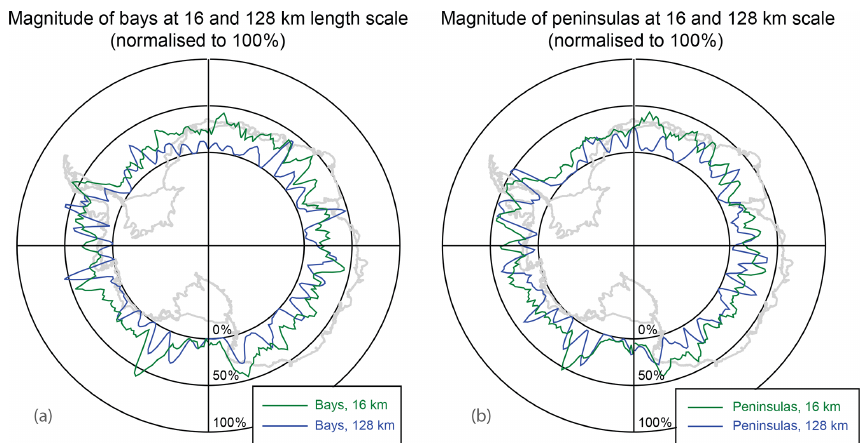
Figure 8. Polar plot showing normalized C x for (a) bays and (b) peninsulas around Antarctica at various 16km (i.e. “short”, corresponding to group 2) and 128km (“long”; group 3) scales, as a function of longitude. The coastline is shown in light